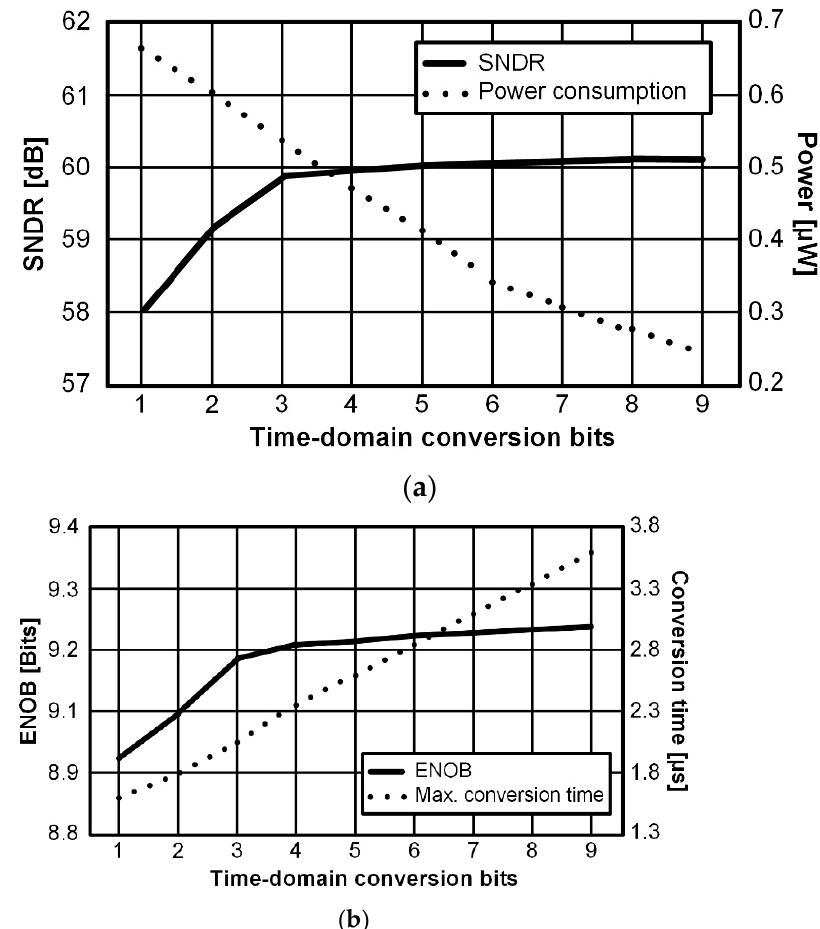
Figure 9. ( a ) Simulated SNDR and power consumption according to fine bits maximum delay and input-referred noise of VCDL according to the number of stages; ( b ) Simulated ENOB and maximum conversion time according to fine bits.